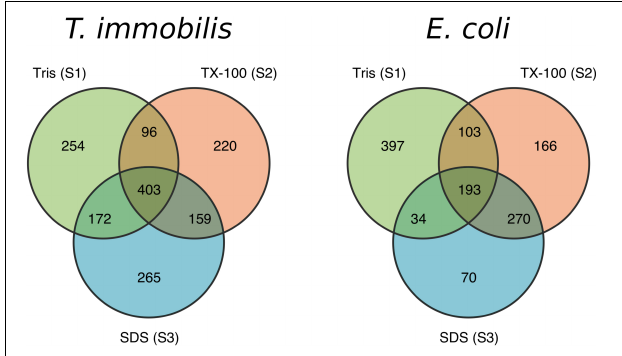
FIGURE 3 | Venn diagram containing the number of unique and overlapping proteins of the three subcellular fractions in T. immobilis and E. coli ; Tris soluble [“Tris (S1)”], Tris/TX-100 soluble [“TX-100 (S2)”] and Tris/SDS soluble [“SDS